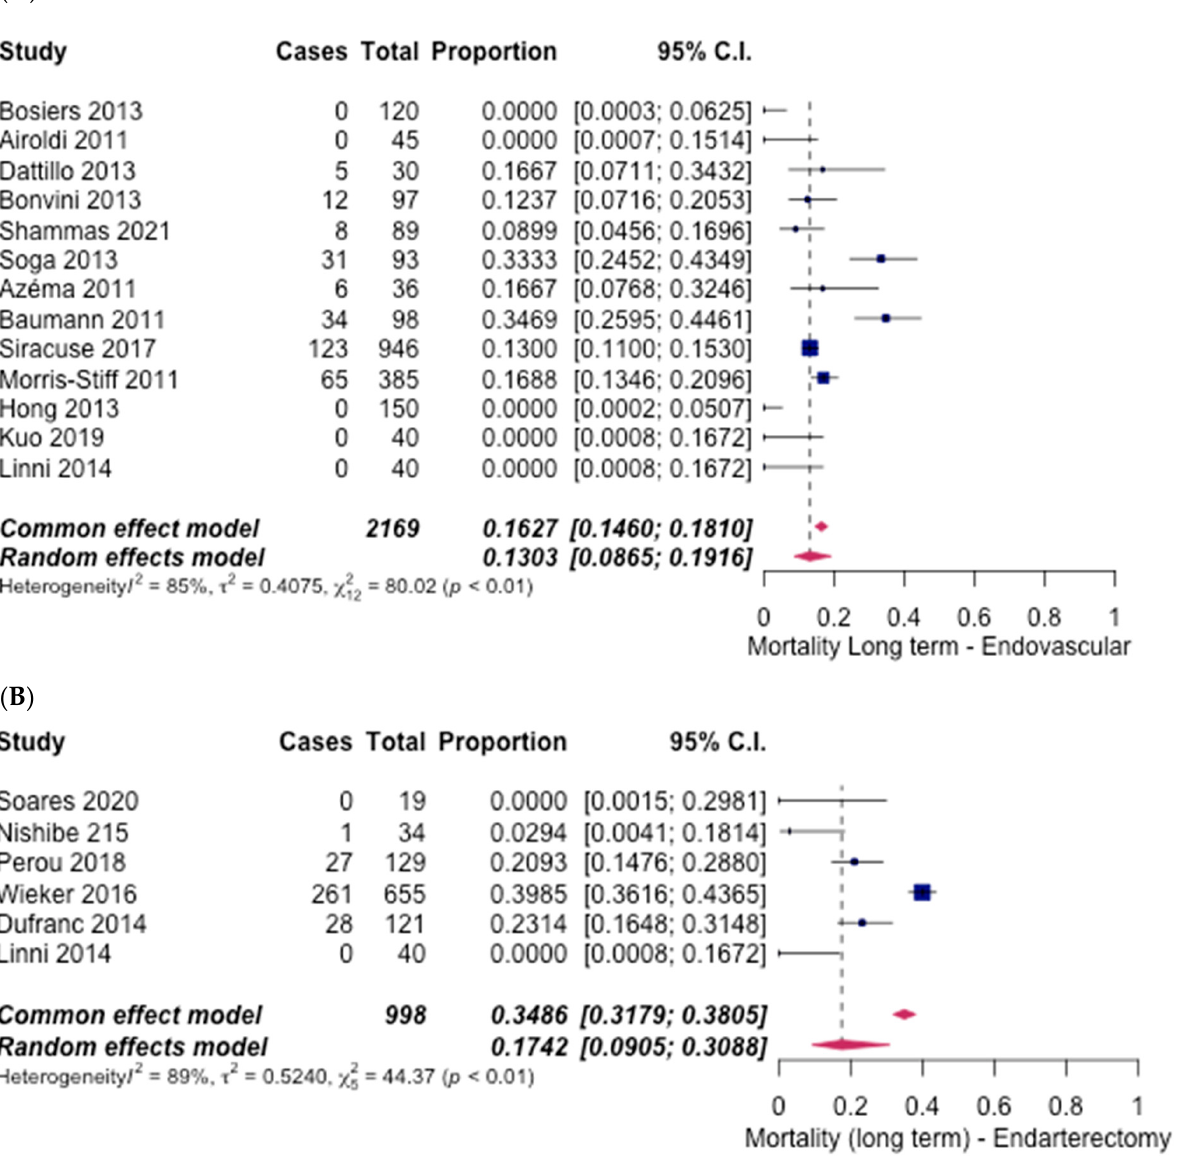
Figure 8. Forest plot for long-term mortality. ( A ) Endovascular intervention [6,8–12,16–21,27]. ( B ) Endarterectomy [6,23–26,28].